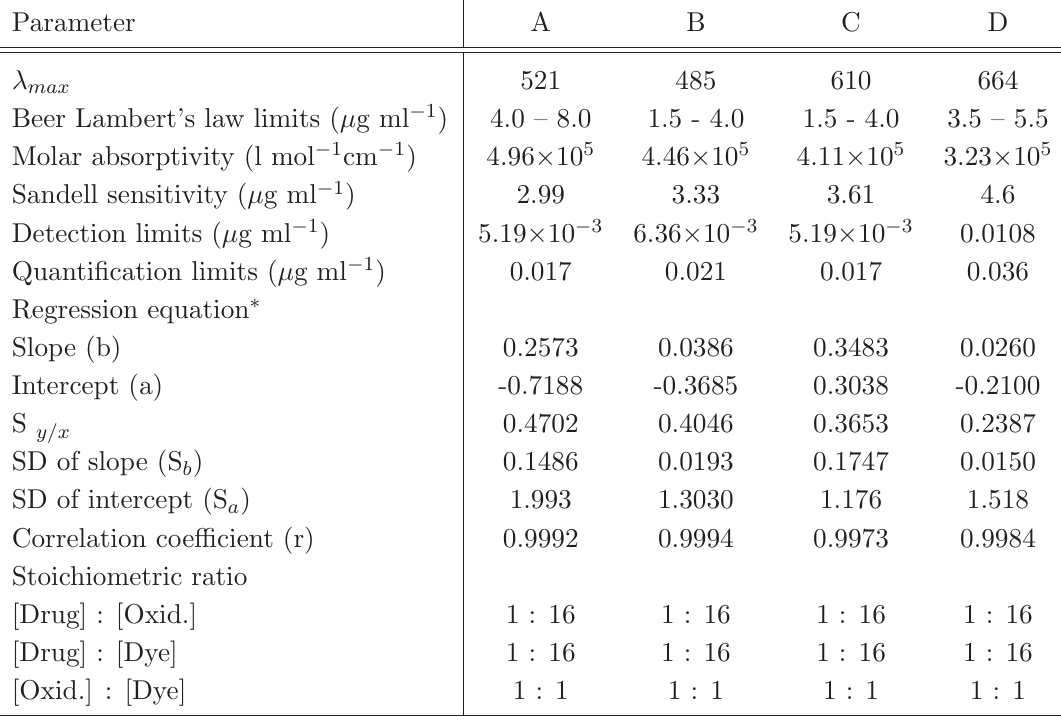
Table 2 Analytical parameters and optical characteristics of the proposed methods with vancomycin